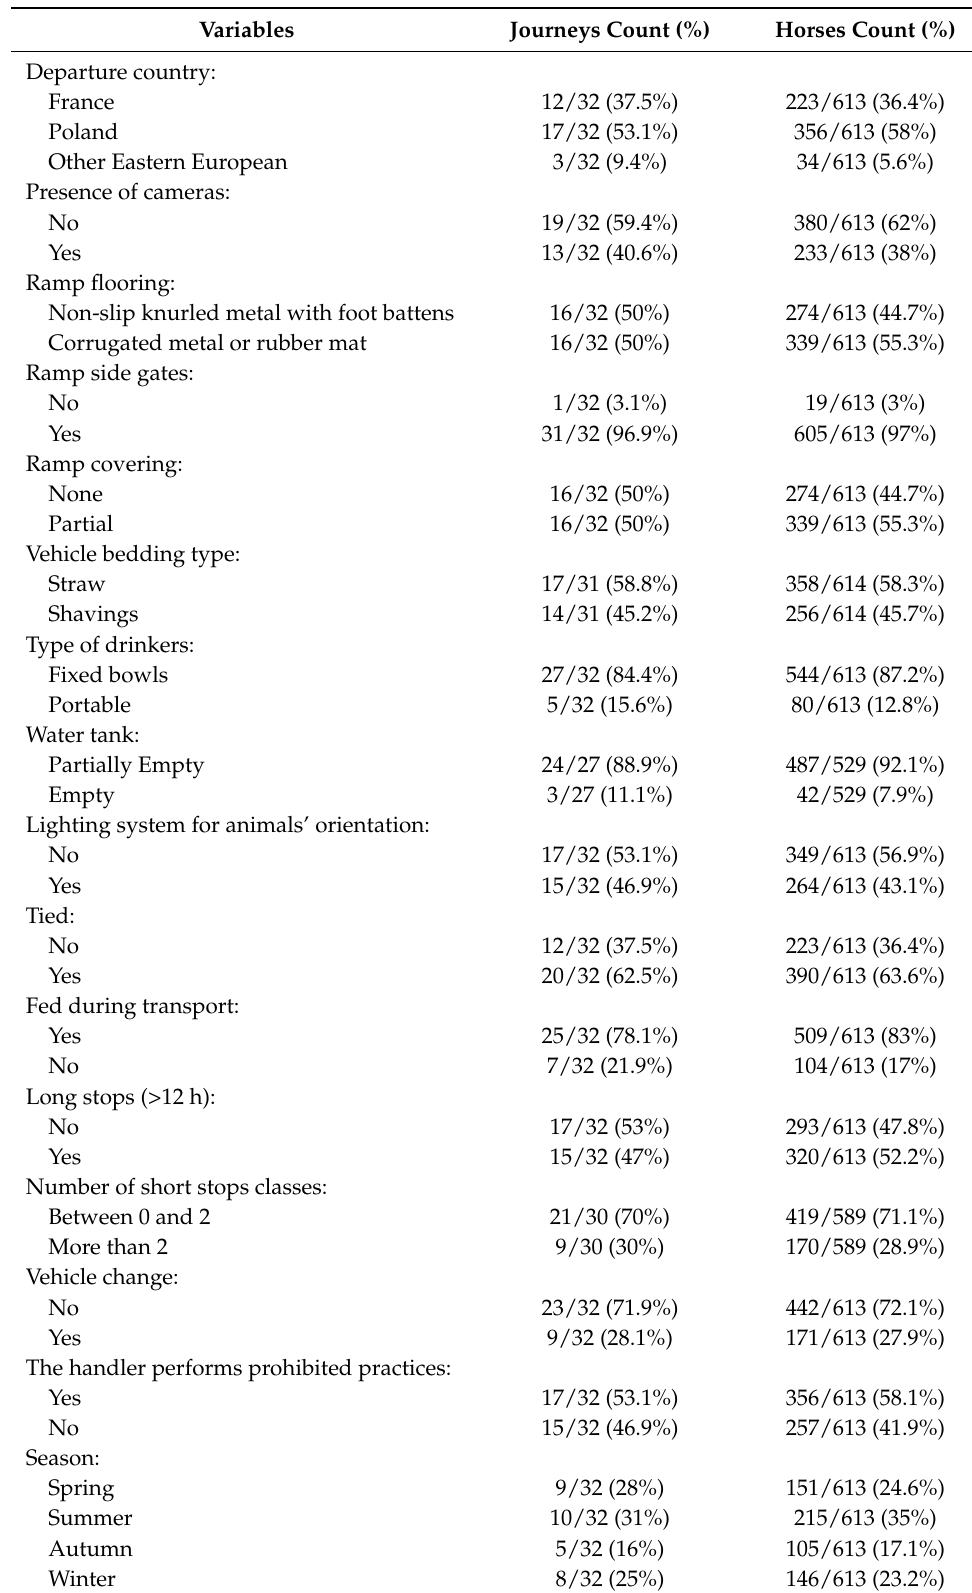
Table 7. Frequency table of journeys (n = 32) and handled horses (n = 613) for the categorical variables related to the vehicle and journey